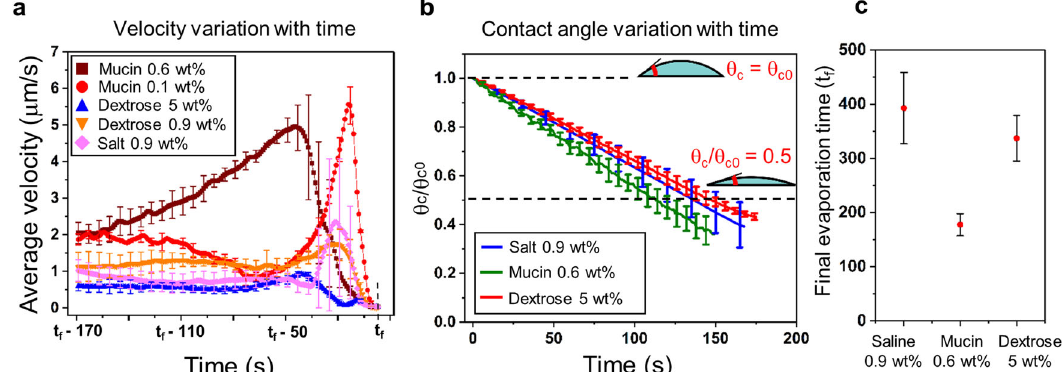
Fig. 5 Velocity and contact angle plots for saline, mucin, and dextrose medium droplets. a Velocity pro fi les for saline and nutrient rich media at the later stages of evaporation. t f is aligned for all media for effective comparison (Supplementary Data 5). b Normalized contact angle variation ( θ c / θ c 0 ) with time for saline, mucin 0.6 wt%, and dextrose 5 wt% (Supplementary Data 6). c t f for saline, mucin 0.6 wt% and dextrose 5